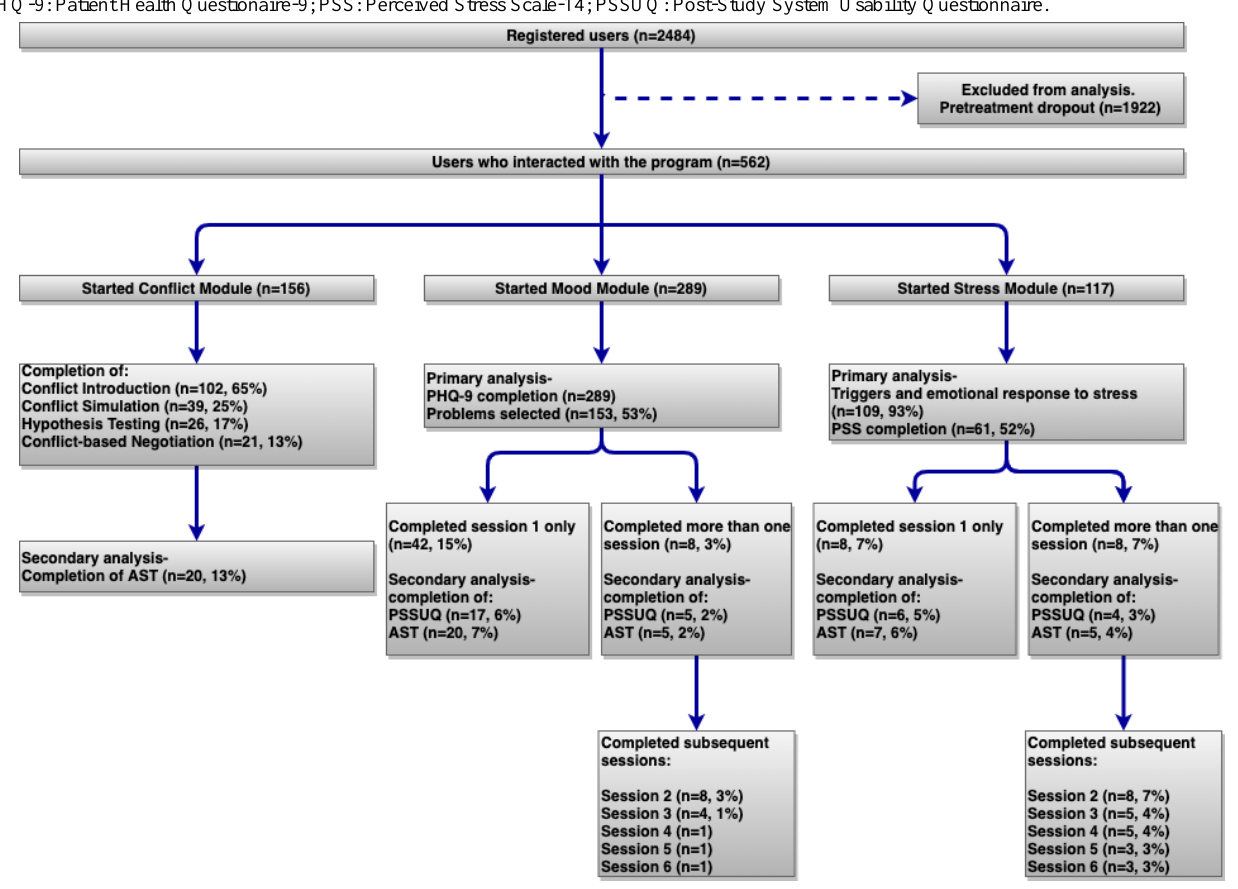
Figure 1. Flow of participants through a self-guided behavior therapy for conflict, mood, and stress. AST: Acceptability of Self-Guided